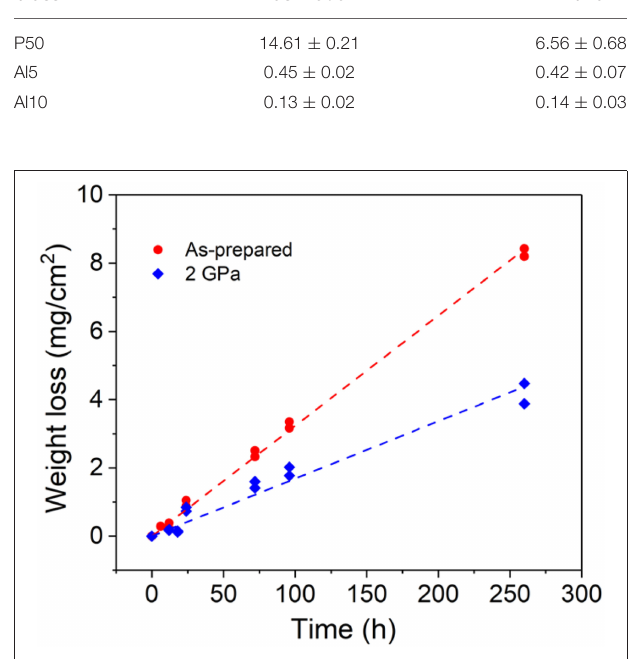
FIGURE 10 | Normalized weight loss (mg cm − 2 ) of the metaphosphate (P50) glass (as-prepared and compressed at 2 GPa) in deionized water as a function of dissolution time. The dashed lines represent linear fits to the data.